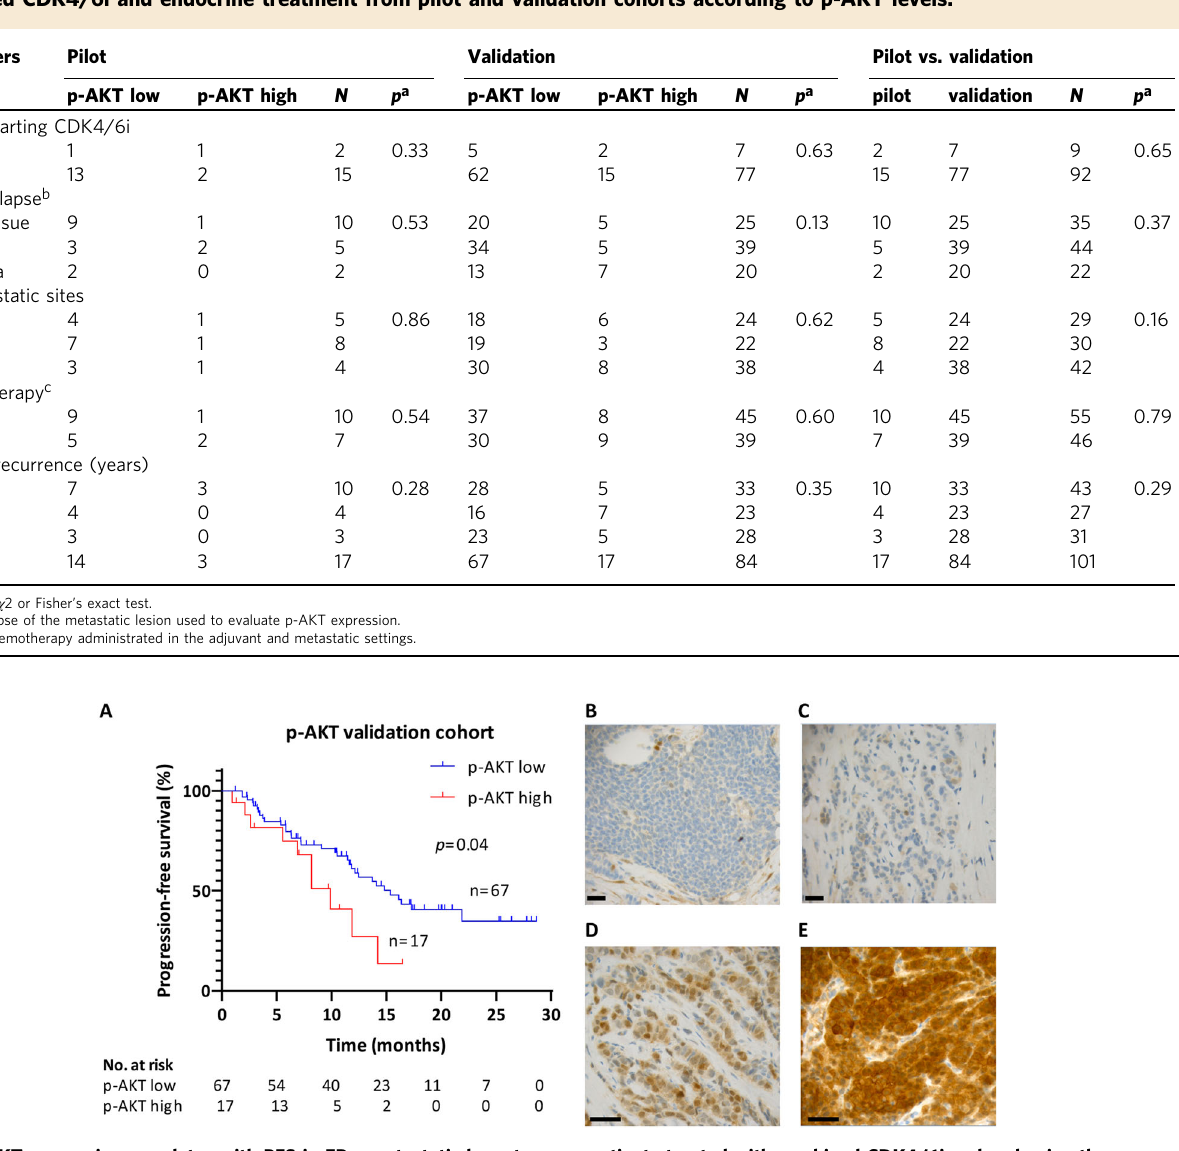
Fig. 7 p-AKT expression correlates with PFS in ER + metastatic breast cancer patients treated with combined CDK4/6i and endocrine therapy. A Kaplan-Meier plots evaluating progression-free survival (PFS) according to p-AKT (S473) levels in ER + metastatic lesions from a validation cohort of ER + breast cancer patients treated with combined CDK4/6i and endocrine therapy in the advanced setting. A two-sided p -value ( p < 0.05) was calculated using log-rank testing. Representative micrographs of all breast cancer metastasis sections showing low p-AKT expression (H-score < 150, B and C ) or high p-AKT expression (H-score ≥ 150, D and E ; scale bars, 100 µ